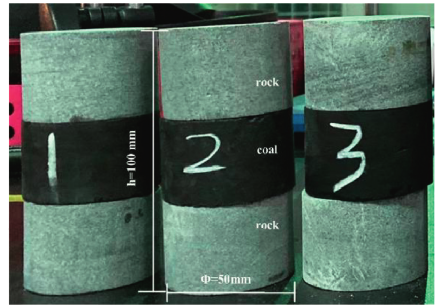
Figure 1: Sample structure and